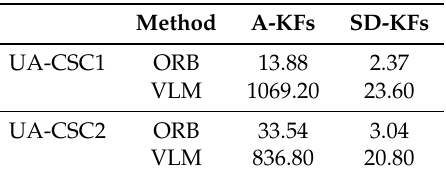
Table 3. Continuous tracking performance, our submap-based system is able to map with a much higher A-KF than ORB-SLAM, since a fault recovery design is involved in VLM.